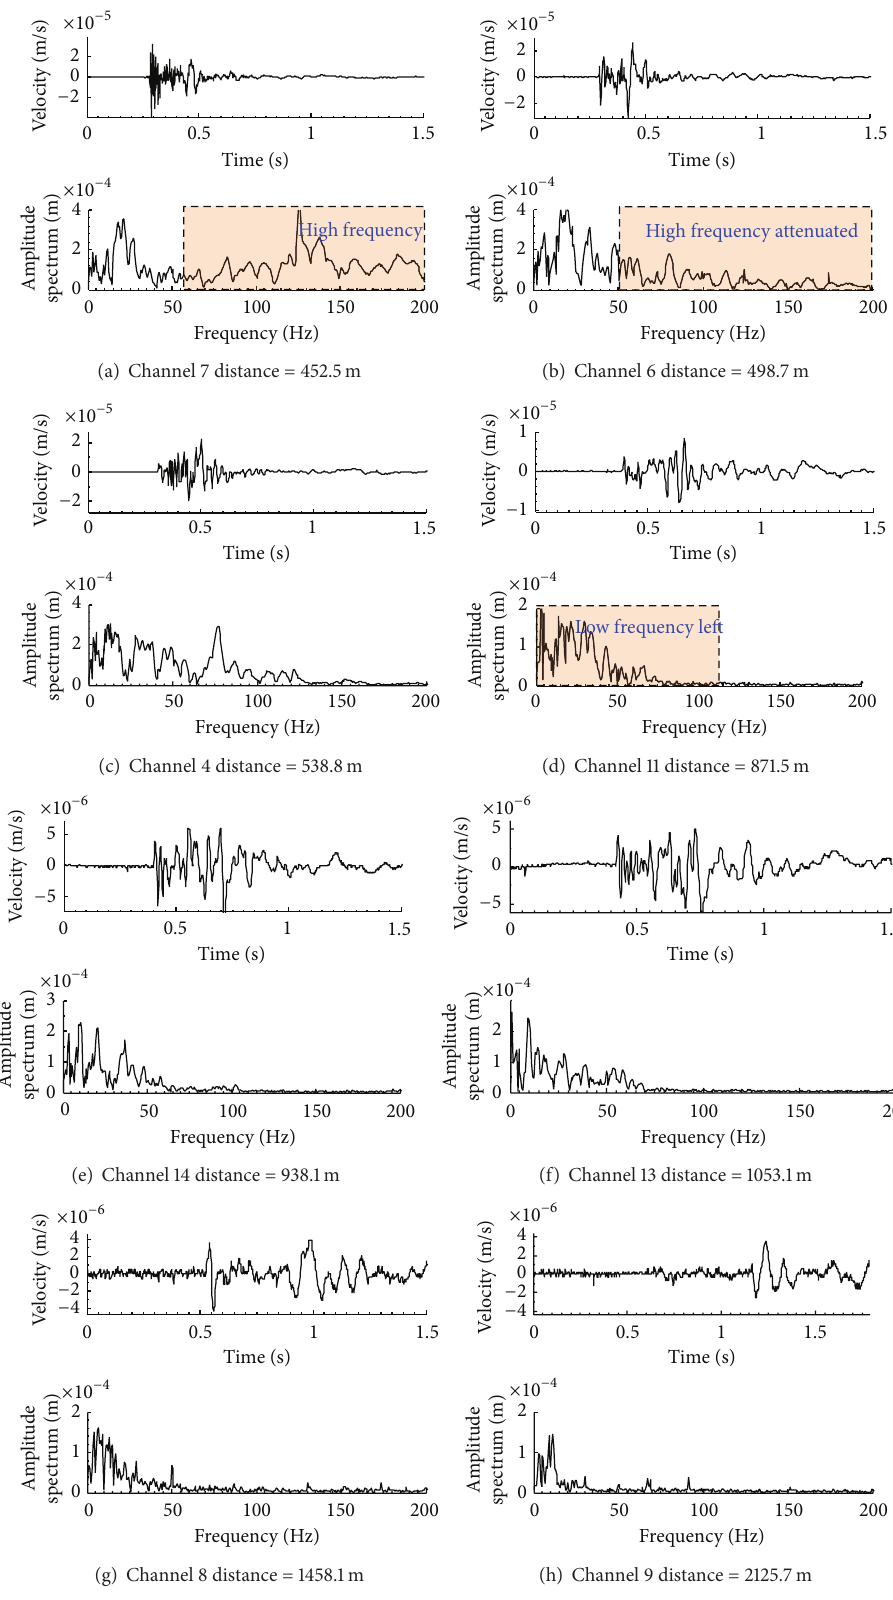
Figure 4: Shockwave and frequency spectrum features in Test